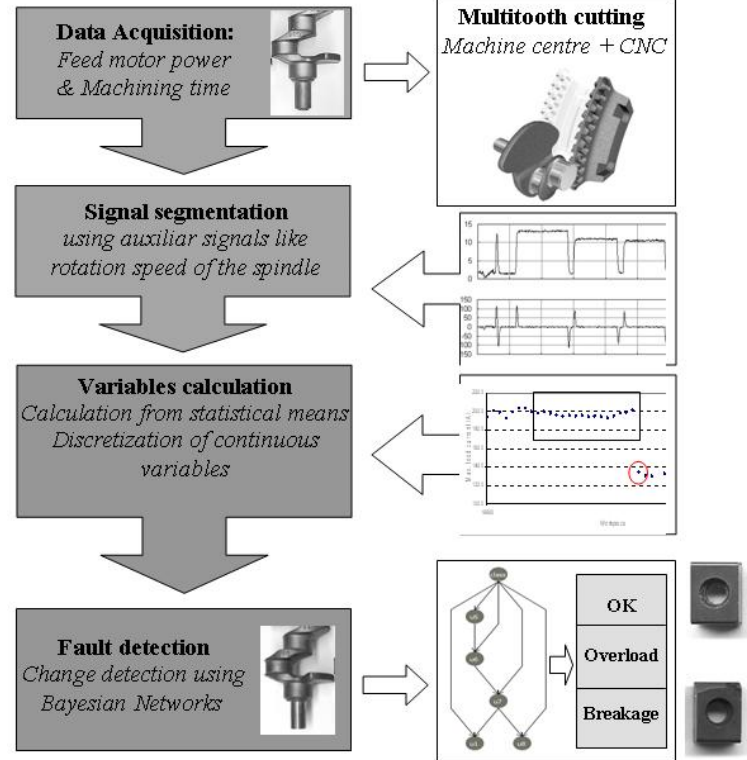
Figure 1. Scheme of the virtual sensor for multitooth fault